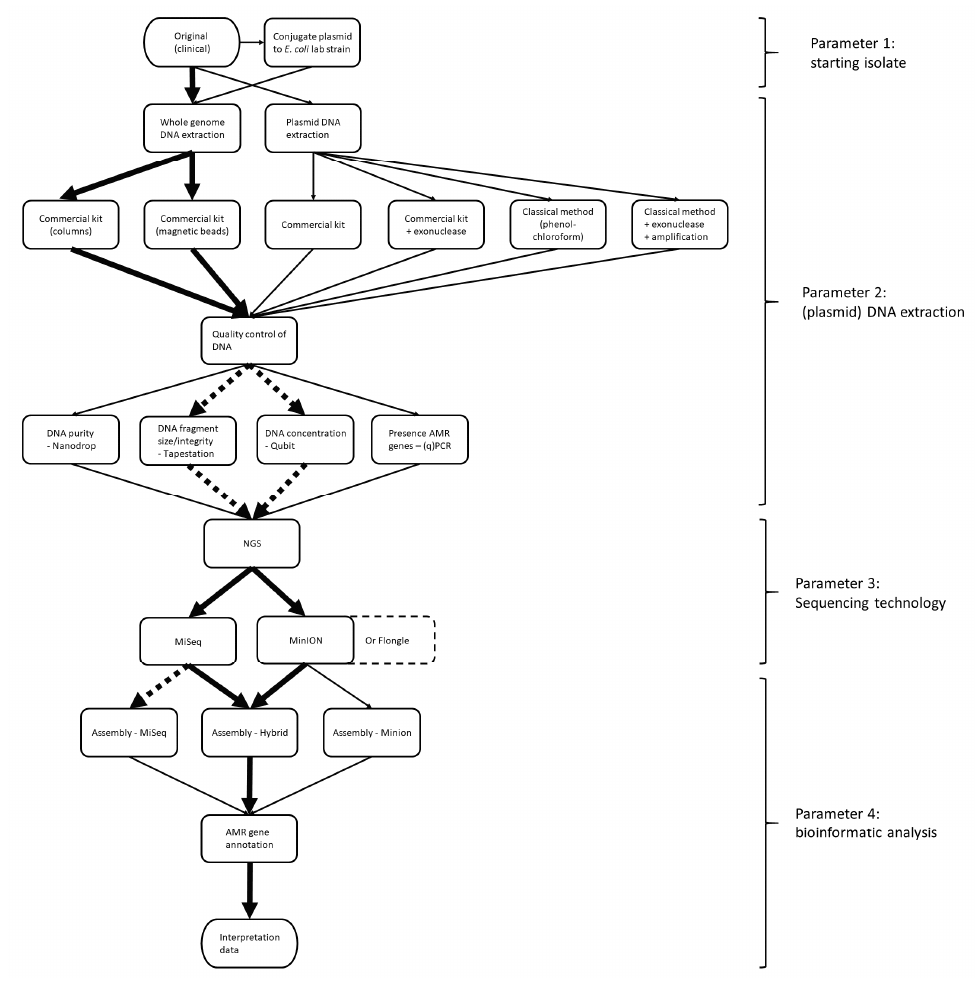
Figure 1. Overview of workflow to reconstruct plasmids with next-generation sequencing and the parameters that were tested. The arrows in bold represent the parameters that were found to be most suitable for reconstructing plasmids. The dashed, bold arrows represent parameters that are optional for the workflow but were determined to be more useful than the nonbold arrows. The box encapsulated in a dashed line represents a parameter that is very similar to the one it is adjacent to.